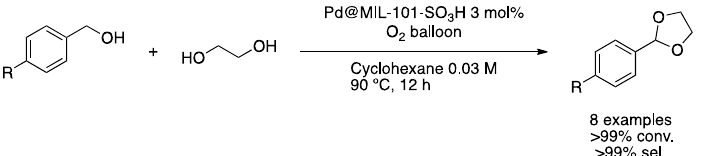
(Figure 5a). Catalysis was conducted on a semi-continuous flow reactor under low hydro-